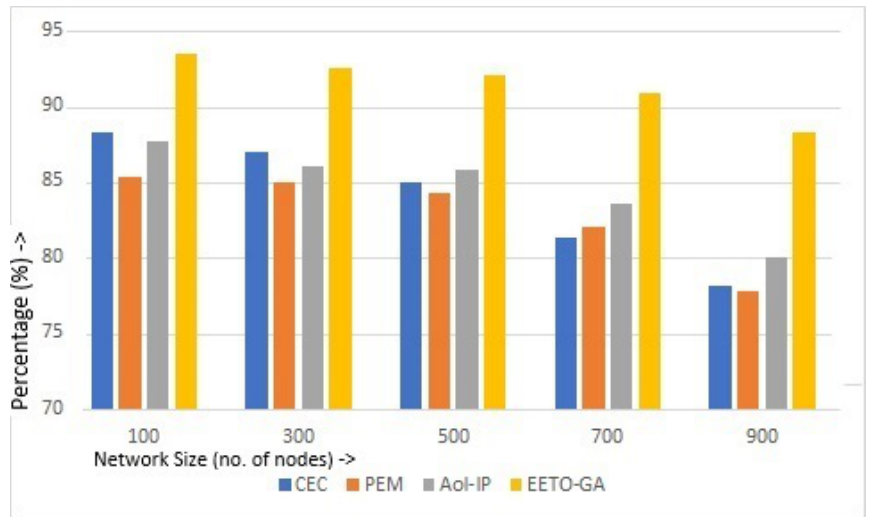
Figure 5. Percentage of successfully completed tasks (PTSK) in proposed EETO-GA and other state-of-the-art.